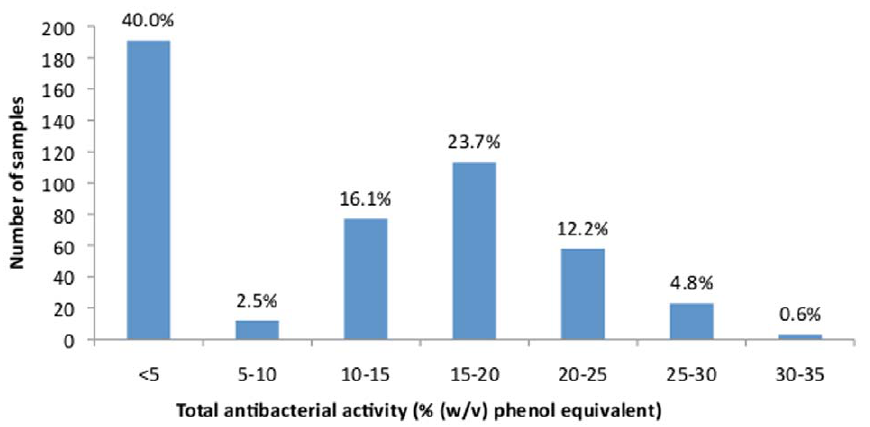
Figure 2. Total antibacterial activity of Australian honey samples. Graph shows combined peroxide and non-peroxide dependent activity in 477 honey samples collected from Australian floral sources, divided into increments of (w/v) phenol equivalent.